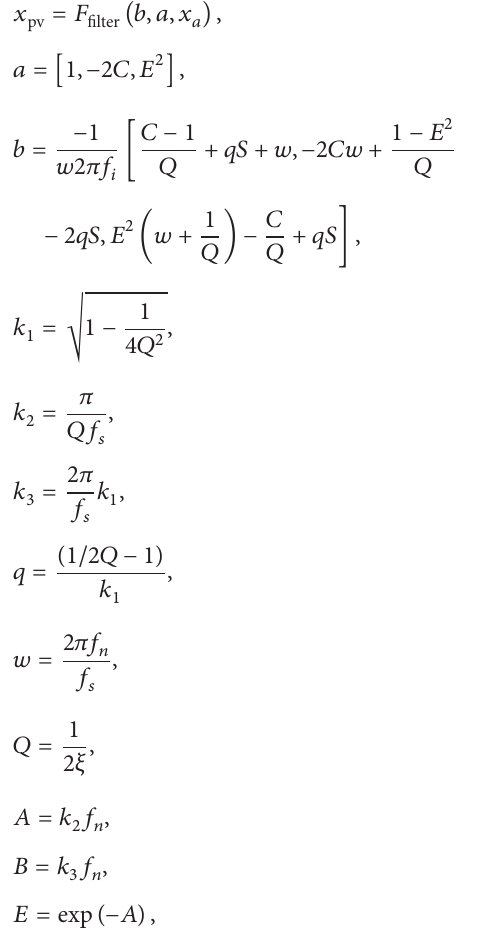
frequency 𝑓 𝑛 and a damping ratio 𝜉 , the output pseudoveloc- to an input acceleration 𝑥 𝑎 can be calculated using a ity 𝑥 pv ramp invariant digital filter method [16]: = 𝐹 (𝑏, 𝑎, 𝑥 ) 𝑥 𝑎 pv filter